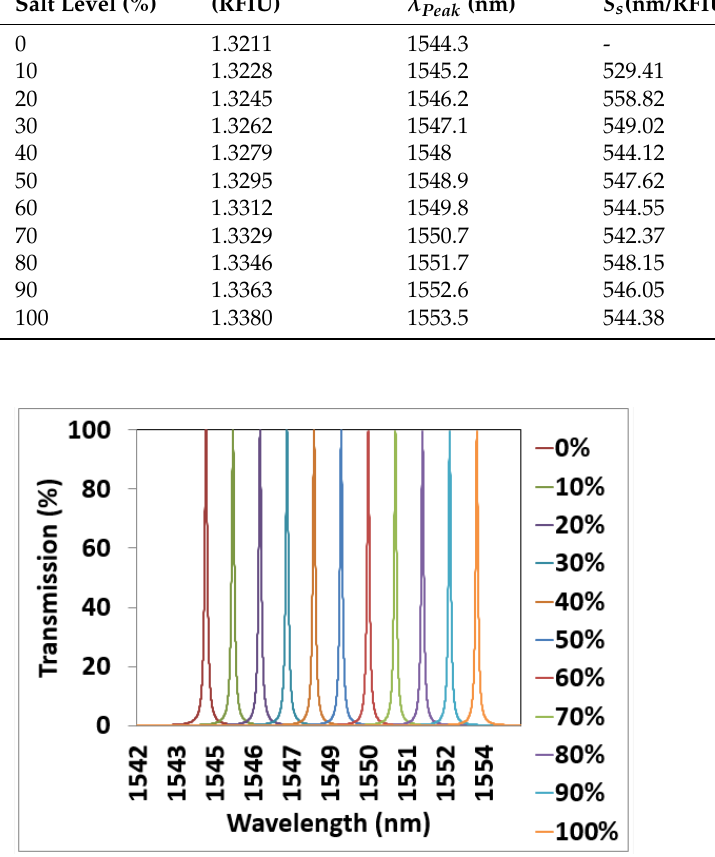
Figure 6. Optical transmittances as functions of wavelength and salt level for a deformed photonic structure with 50 alternated layers of fused silica and TiO 2 and with a middle cavity filled with seawater at room temperature.